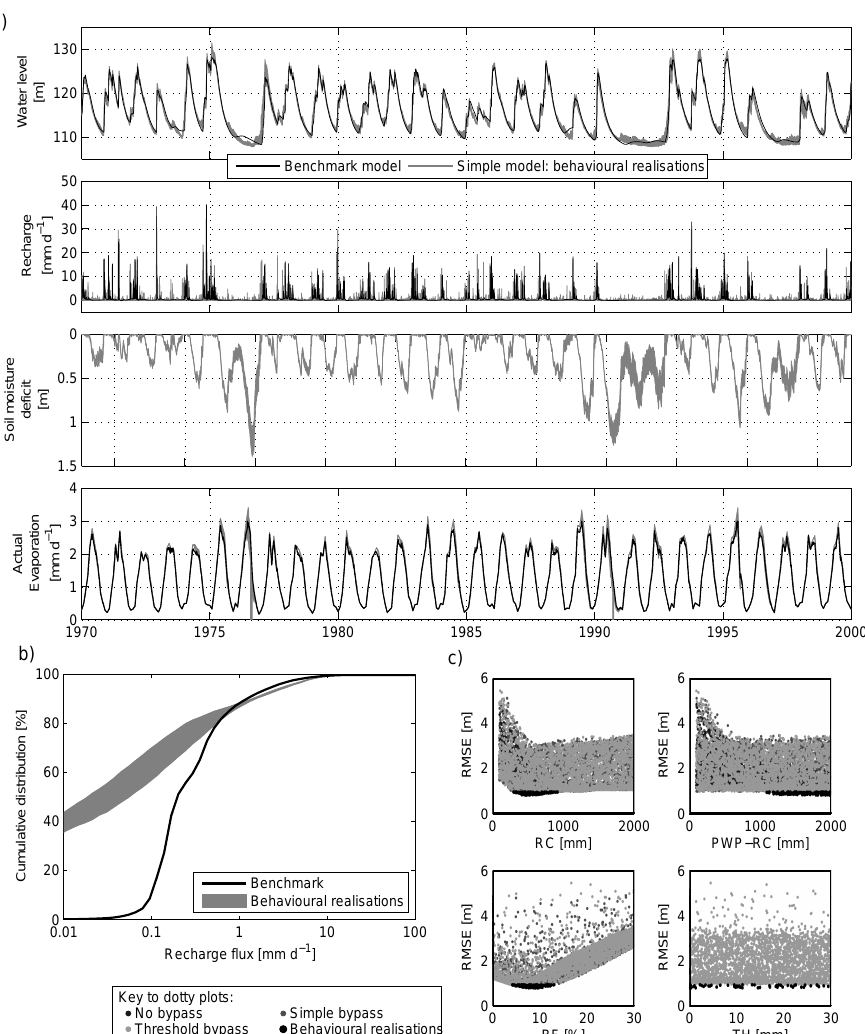
Fig. 6. Results from the simple model using a daily time step . (a) Performance of the simple model (grey lines) in reproducing benchmark (black lines) water table, recharge, soil moisture status and actual evaporation; (b) cumulative distribution of recharge fluxes; (c) parameter identifiability.